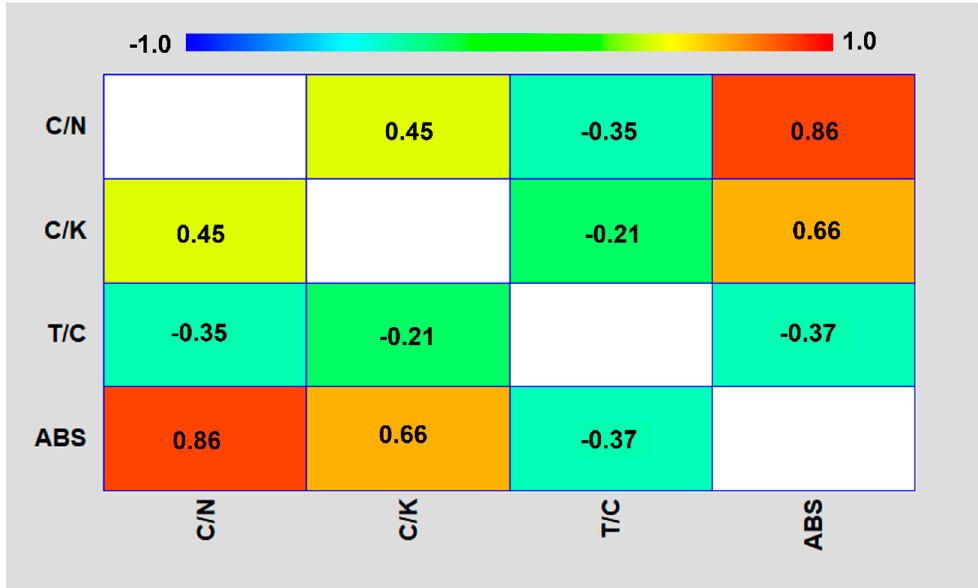
12 of 18 Table 6. Fermentation data. Independent variables: C/N and C/K ratios; dependent variable: absorb- ance at 1060 cm − 1. Experiment